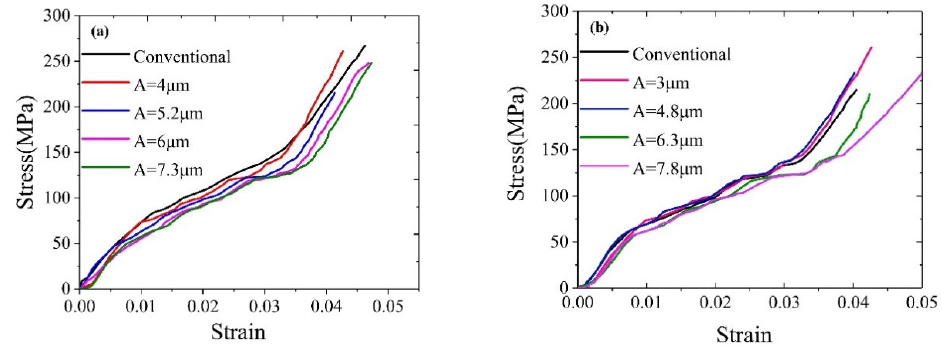
Figure 17. The experimental stress-strain curve under di ff erent amplitude conditions: ( a ) 20 kHz, and ( b ) 28 kHz.